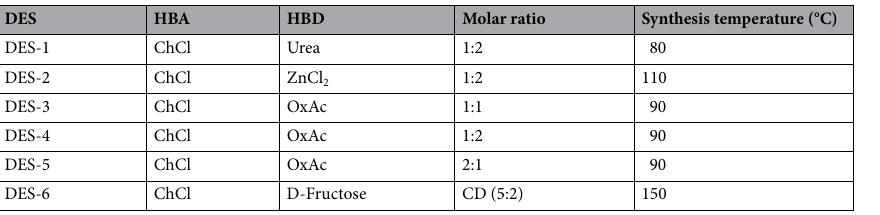
Table 1. Deep eutectic solvents’ preparation conditions. ChCl = choline chloride, OxAc = Oxalic acid dihydrate, DES-1 = ChCl:Urea (1:2), DES-2 = ChCl:ZnCl 2, DES-3 = ChCl:OxAc (1:1), DES-4 = ChCl:OxAc (1:2), DES-5 = ChCl:OxAc (2:1) and DES-6 = ChCl:D-Fructose (5:2).